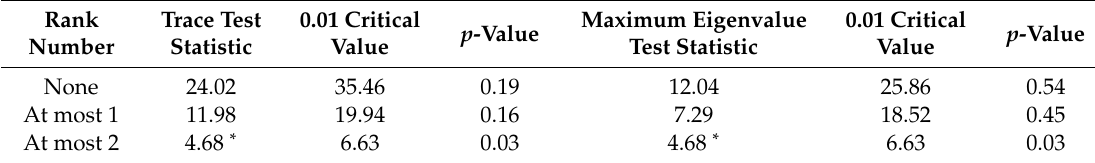
Table 4. Results of the Johansen cointegration test for JPY ( E2 t ,PL t , PJ t )